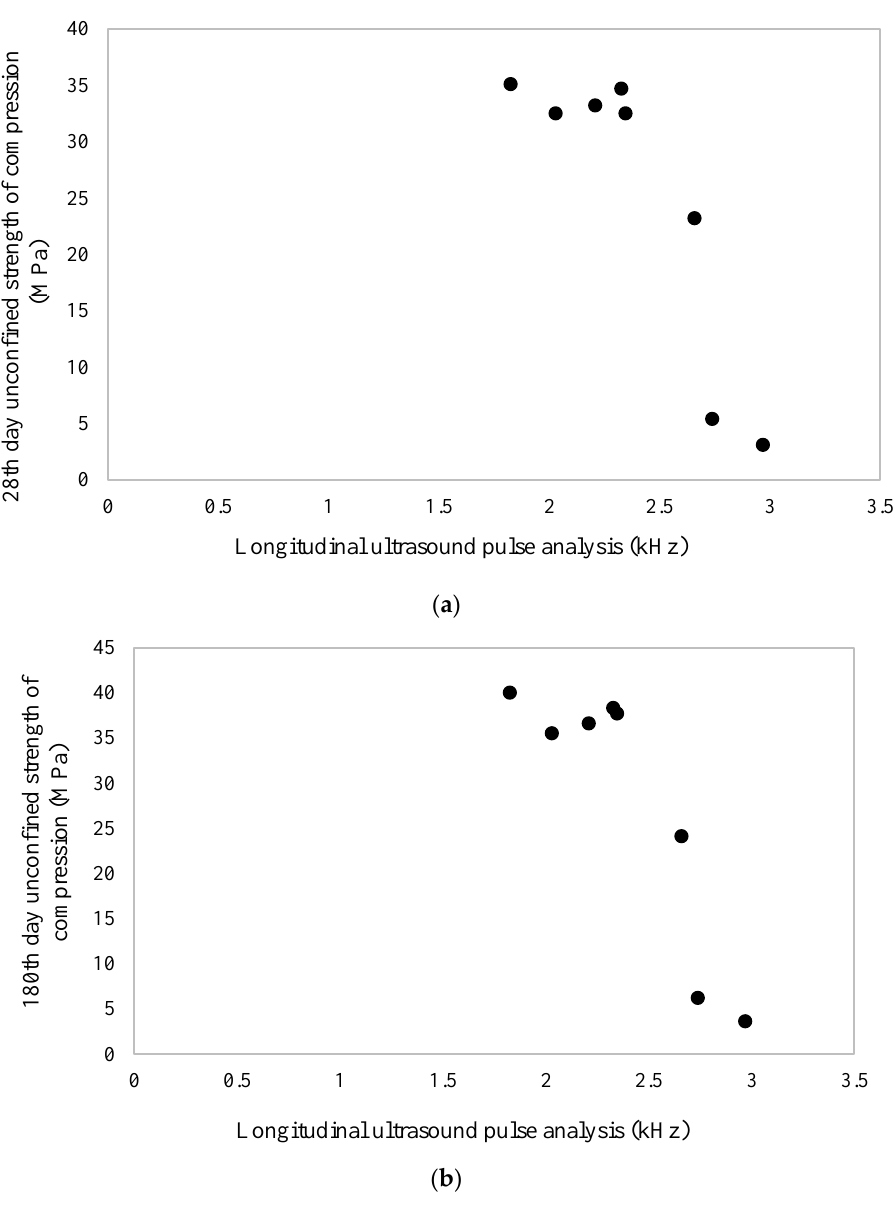
Figure 2. Correlation among the unconfined strength of compression and longitudinal UPA on the ( a ) 28th day and ( b ) 180th day. The suggested math models for predicting the unconfined compressive strength Table 3. Calibration equations for predicting unconfined strength of compression from longitudinal UPA on the 28th day and 180th day are demonstrated in Equations (1) and (2), respectively, in Table 3.